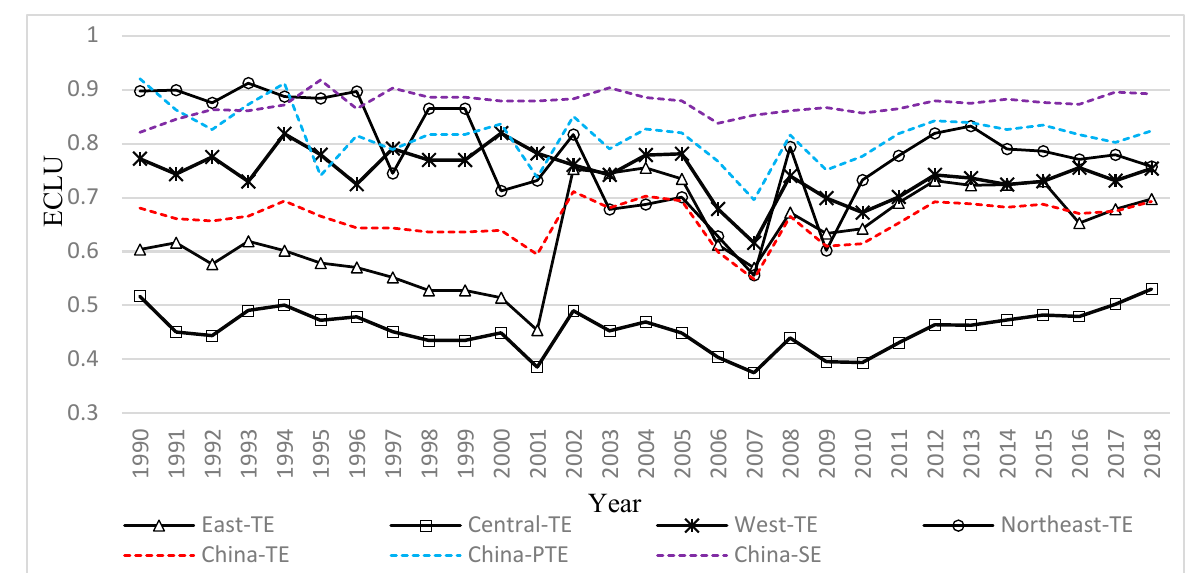
Figure 2. The evolution of the ECLU at the country and regional levels from 1990–2018.